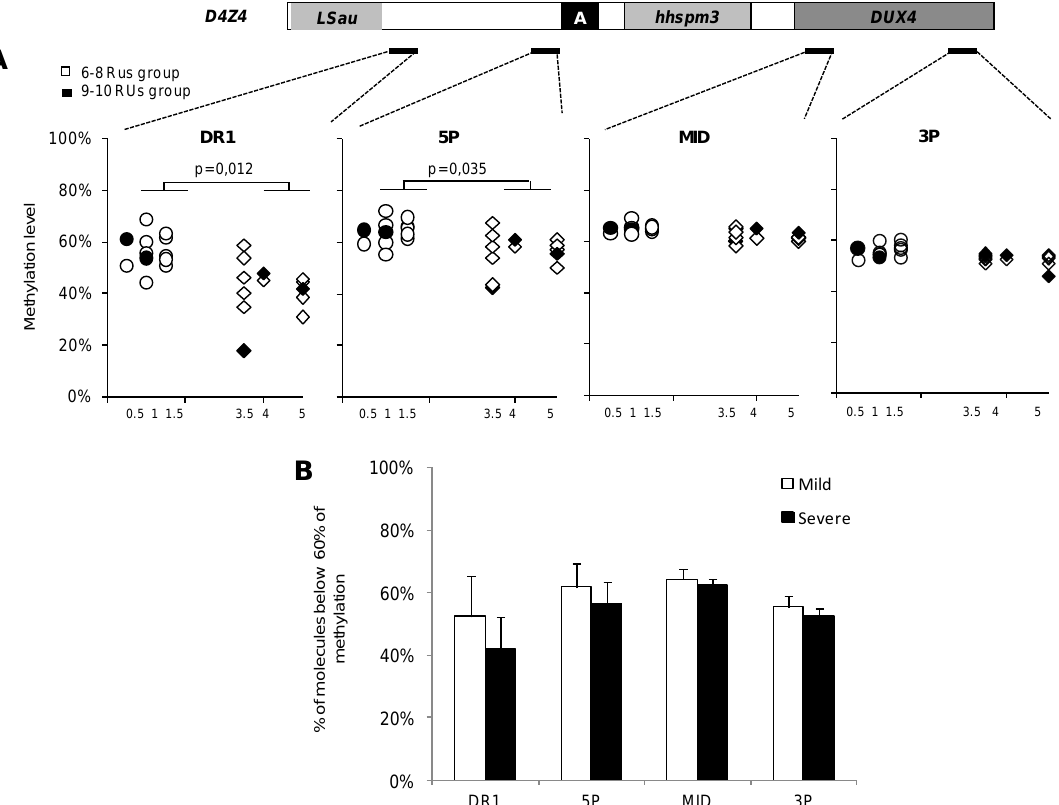
Figure 1. The percentage of methylation in patients with a low severity score ( < 1.5) compared to patients with a high severity ( > 3.5), patients from the 6–8 repeat units (RUs) group are represented by white dots, patients from the 9–10 RUs group are represented by black dots (panel A ). The percentage of DNA molecules below 60% of the methylation level is also illustrated (panel B ). Hypomethylation was more significantly pronounced in patients with a high severity score than in those with a low severity score, especially for the proximal D4Z4 region (DR1 and 5P). Table 1. Comparison of clinical scales between the two groups of patients with facioscapulohumeral